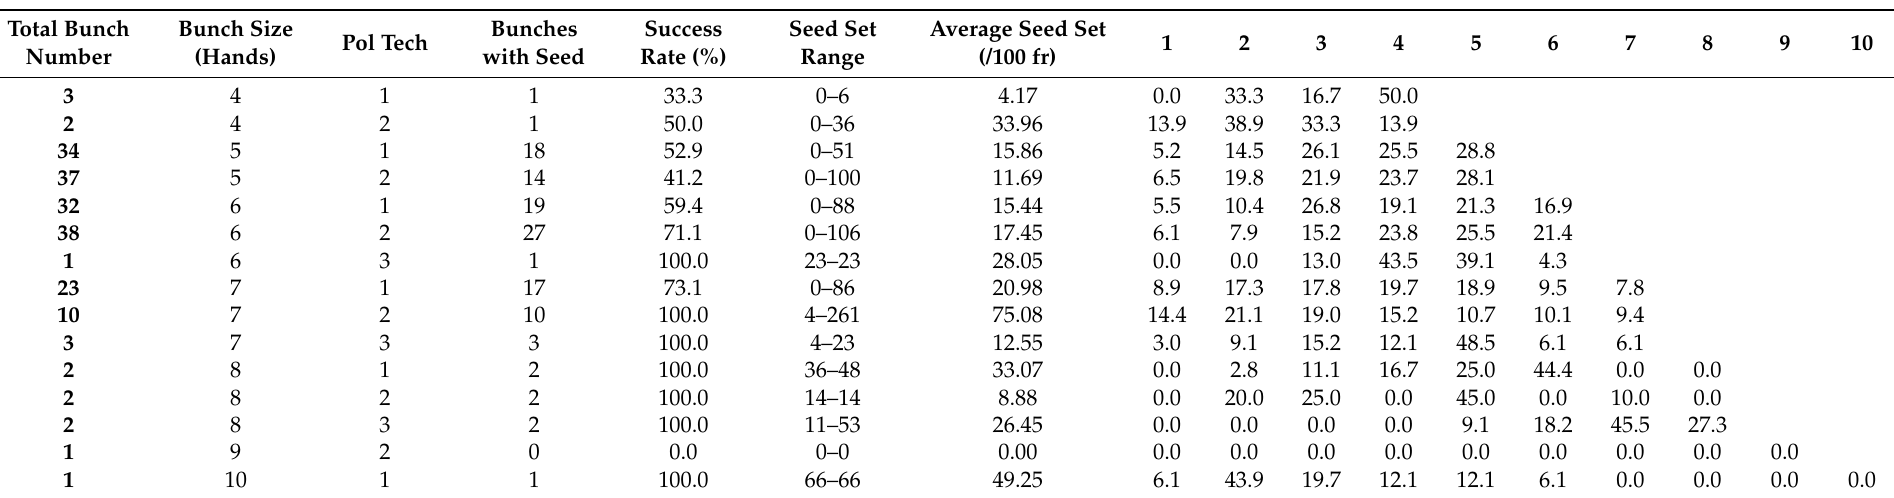
Table A2. Percentage seed set per hand and by number of hands per bunch in “Mshale”, pollinated with “Calcutta 4”, using different pollination techniques, between January 2016 and January 2019.